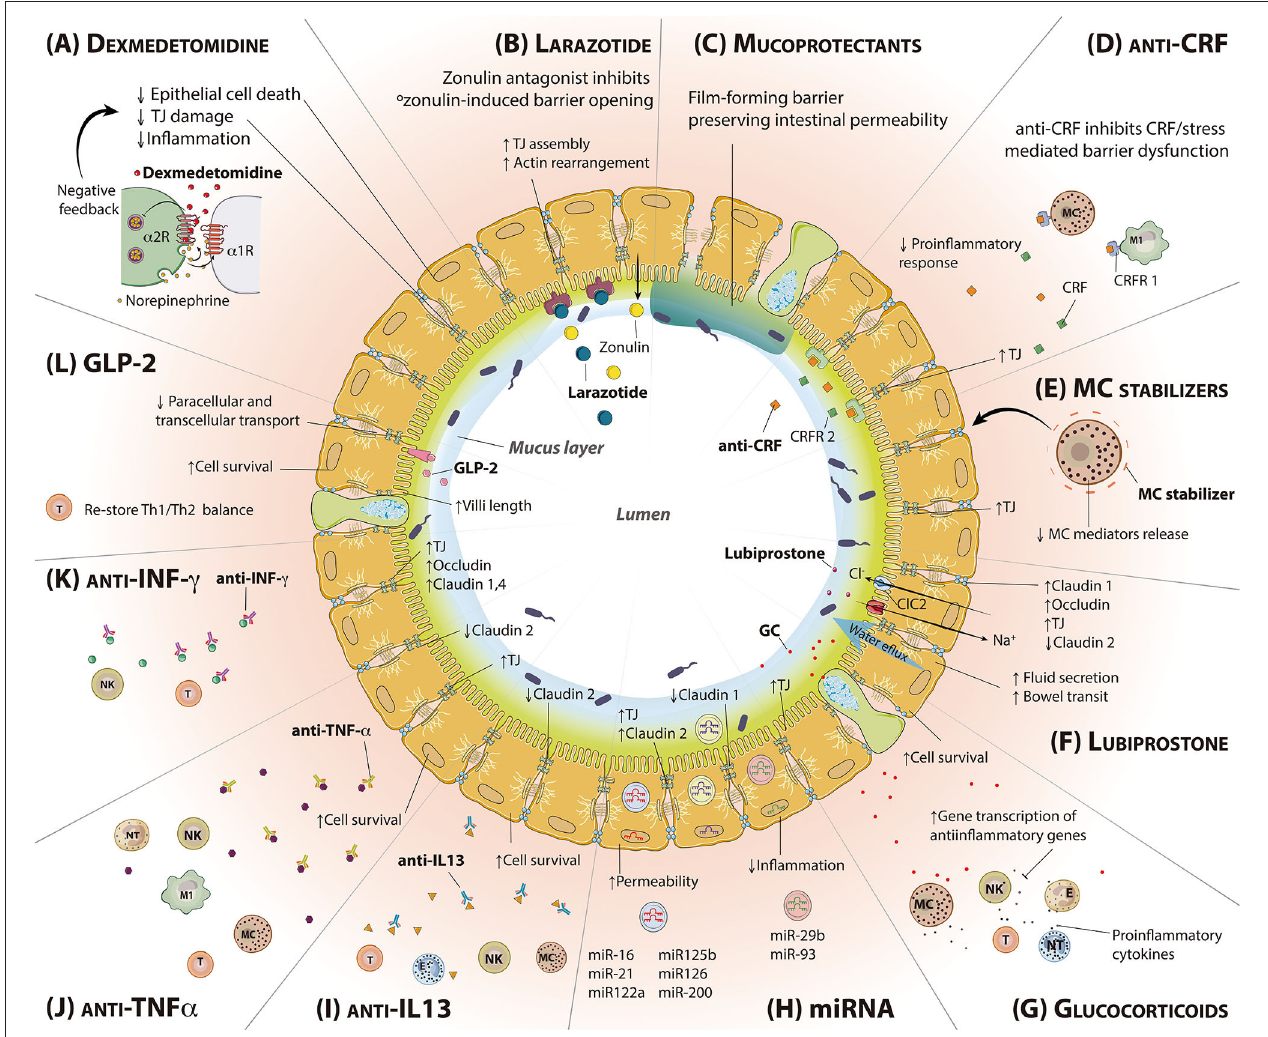
FIGURE 3 | Molecules intended to regulate intestinal permeability and/or mucosal inflammation. Representation of a transversal section of the small intestine, including epithelial and goblet cells. The mucus layer and the lumen are found inside; the lamina propria is outside. (A) Dexmedetomidine reduces epithelial cell death, TJ damage and inflammation. (B) Larazotide is a zonulin antagonist, able to bind zonulin receptor and block its toxic effects. (C) Mucoprotectants cover the epithelial cells surface forming a film barrier that helps to preserve intestinal permeability. (D) CRF antagonist binds to CRF receptors blocking the binding of stress-released CRF and decreasing subsequent proinflammatory responses. (E) MC stabilizers are responsible for MC cell membrane stabilization inhibiting degranulation. (F) Lubiprostone increases water flux to the intestinal lumen and bowel transit, enhancing the expression of TJ proteins. (G) Glucocorticoids inhibit the activation of the immune system via transcription of anti-inflammatory genes. (H) miRNA exert different roles within the epithelial barrier regulation, being able to enhance the intestinal permeability or reducing inflammation (I) Anti-IL-13 treatment inhibits IL-13 effects in the IEB, increasing cell survival and decreasing the expression of the pore-forming TJ claudin 2. (J) Anti-TNF- α increases cell survival and TJ expression while decreases claudin 2 expression through TNF- α antagonism. (K) Anti-INF- γ treatment inhibits INF- γ effects in the IEB, increasing the expression of TJs. (L) GLP-2 binds to GLP-2R, predominantly expressed in the intestinal tract, resulting in